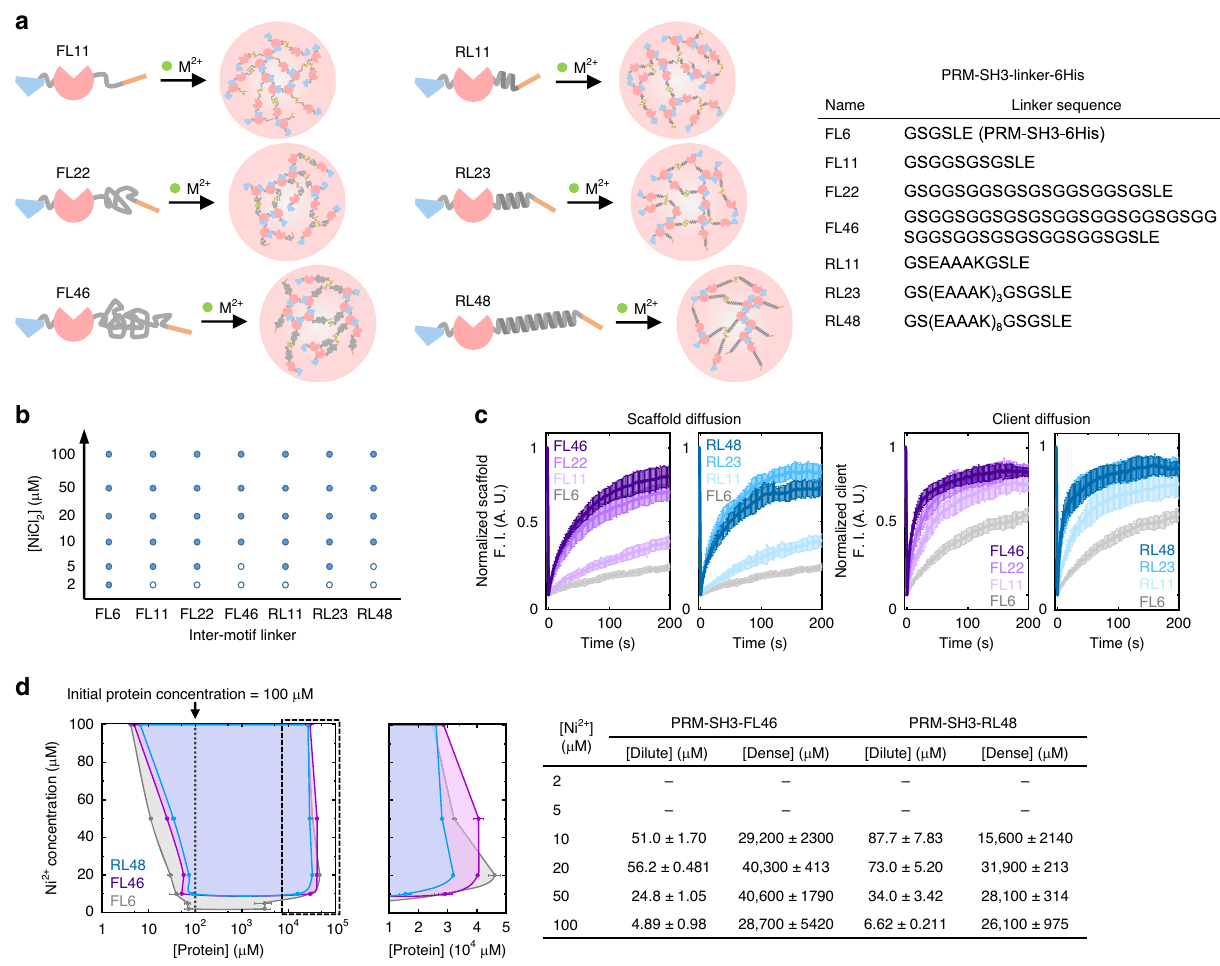
Fig. 5 Condensate property alternation by engineering inter-binding motif linkers. a Schematic illustration of metal ion-induced phase separation with linker-modi fi ed scaffold proteins. Added linker sequences of PRM-SH3-Linker-6His are shown in the right table. b A phase separation diagram of PRM- SH3-Linker-6His as a function of metal ion concentrations. c FRAP recovery pro fi les of PRM-SH3-Linker-6His (left images) and client PRM-SH3 (right images) inside condensates (analysis after 0.5 h upon metal addition). d The phase diagrams of PRM-SH3-Linker-6His with dense and dilute phase protein concentrations (analysis after 24 h upon metal addition). The FL6 data are same as Fig. 2e, but included for better comparison with the FL46 and RL48 data. Error bars: 1 s.d. ( n =